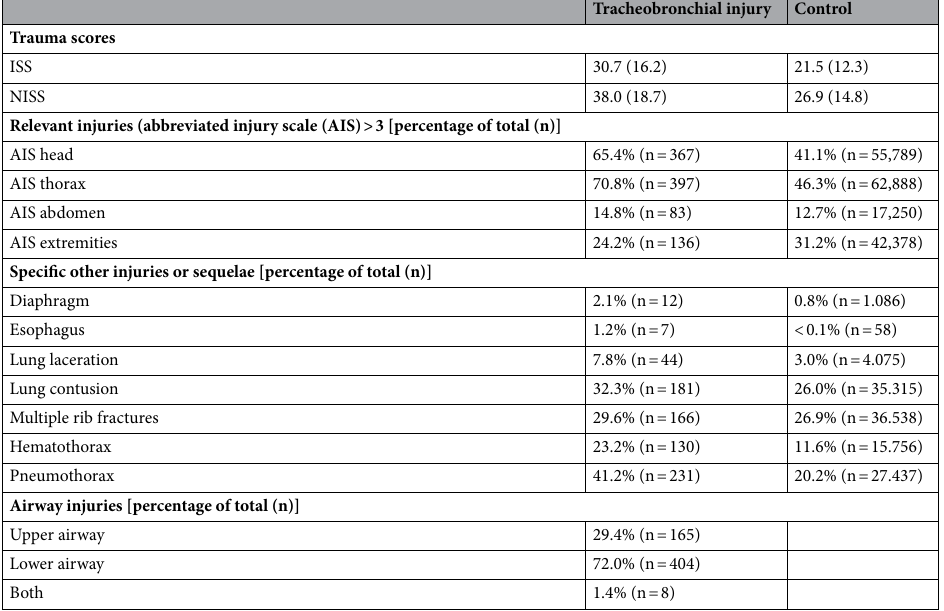
Table 2. Injury severity and concomitant injuries (ISS: Injury Severity Score; NISS: New Injury Severity Score; AIS: Abbreviated Injury scale) of all patients and of all those with tracheobronchial